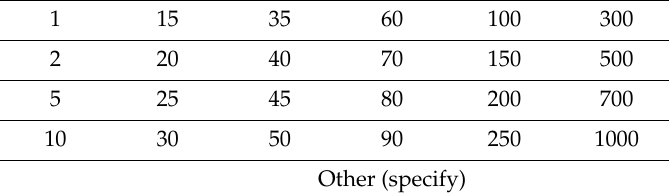
Table 2. Card proposed to each respondent for the selection of his / her willingness to pay (USD).